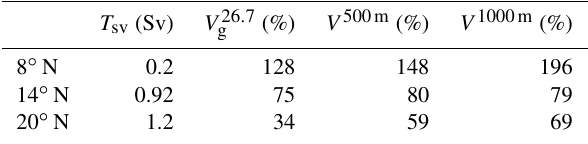
Table 1. Climatological Sverdrup transport T sv (geostrophic part, see Sect. 2) computed from DFS5.2 winds over across-shore sec- tors from the shelf break to 150km offshore for three different lati- tudes ranges (2 ◦ wide centered over the latitude reported in the first column). Model geostrophic transports computed over the same ar- eas are indicated as a percentage of T sv for three different ranges of vertical integration from the surface to σ t = 26 . 7 ( V 26 . 7 g , third column), 500m ( V 500m , fourth column), or 1000m ( V 1000m , fifth column).